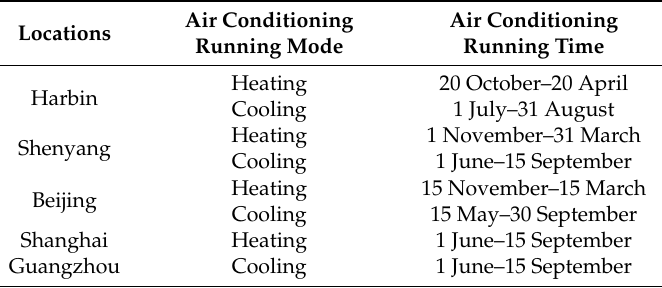
Table 6. Air conditioning running time in different areas.